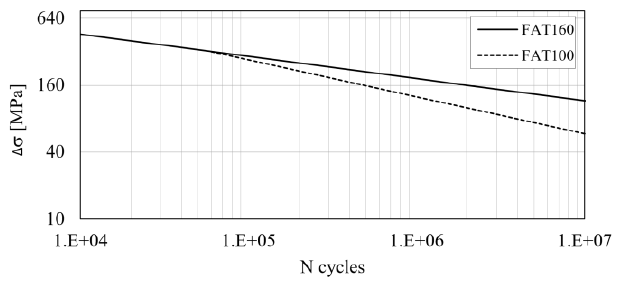
Figure 15. Fatigue resistance S–N curves [19]. Table 1. Results of fatigue calculations.